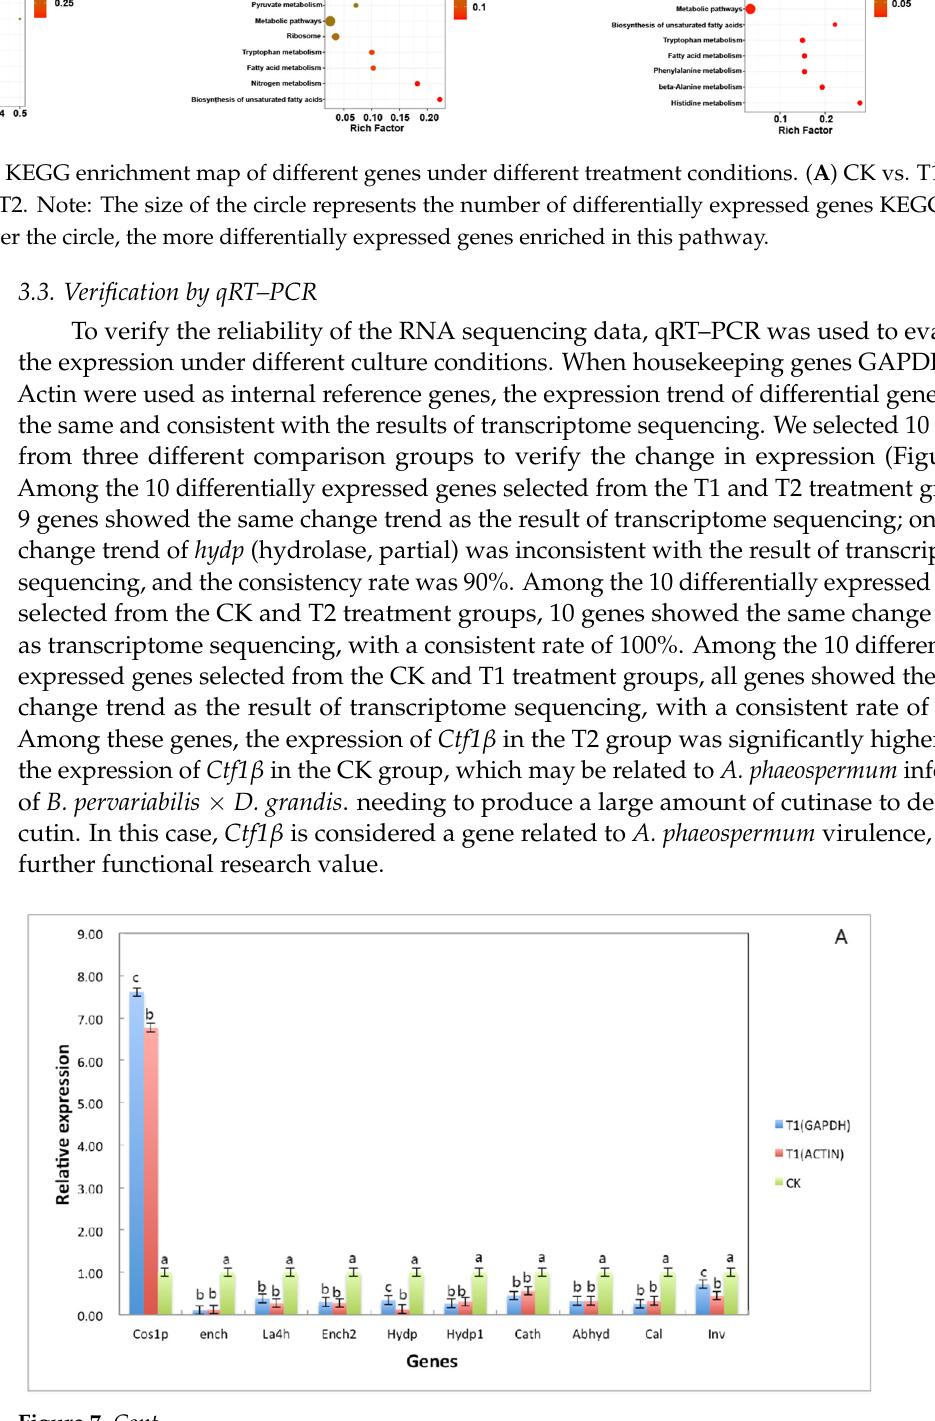
Figure 7. The differential gene expression under different treatment conditions was verified by fluorescence quantitative analysis. Note: ( A ) refers to the detection results of 10 differential gene expressions under two different culture conditions of sterile deionized water and sterile rice tissue fluid; ( B ) refers the detection results of 10 differential gene expressions under two different culture conditions of sterile deionized water and sterile tissue fluid of B. pervariabilis × D. grandis .; C refers the detection results of 10 differential gene expressions under two different culture conditions of sterile rice tissue fluid and sterile B. pervariabilis × D. grandis . tissue fluid. All assays were repeated three times, the data were analyzed using one-way ANOVA and Duncan’s range test in SPSS 16.0. Different lowercase letters showed that there were significant differences in the expression level of